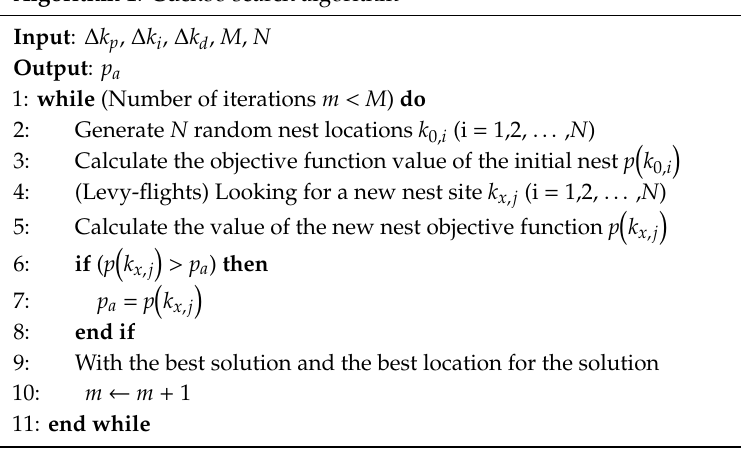
Algorithm 1 . Cuckoo search